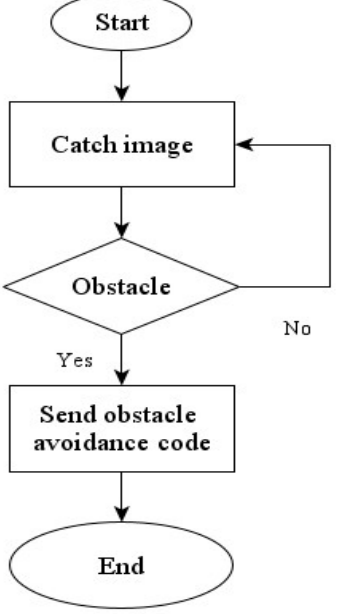
Figure 13. Image recognition process flow chart.